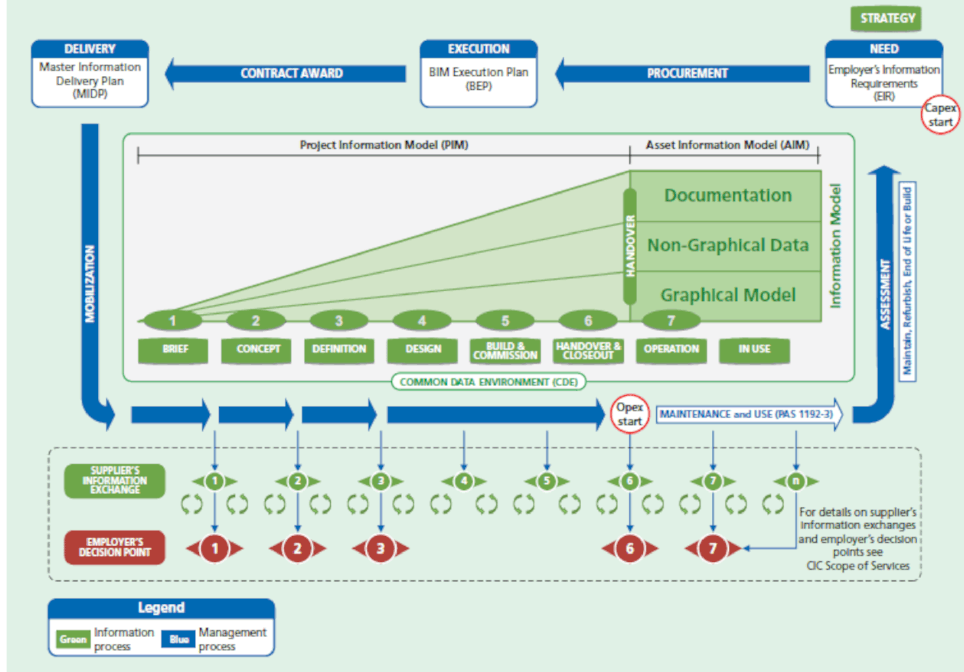
Figure 1. Information Delivery Lifecycle as in PAS 1192-2 (BSI, 2013), reused with permission from ©